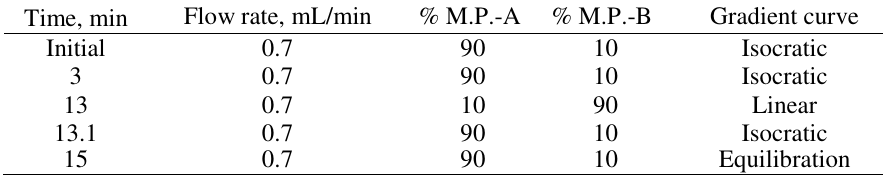
Table 2. Gradients program for elution of 5-ASA and all